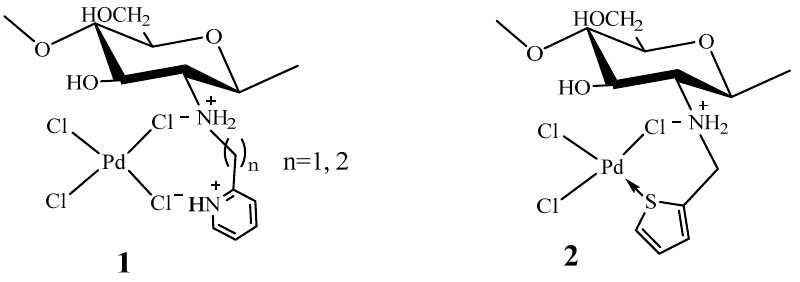
Figure 14. Suggested structures of quasi-chelates with Pd(II) anions.